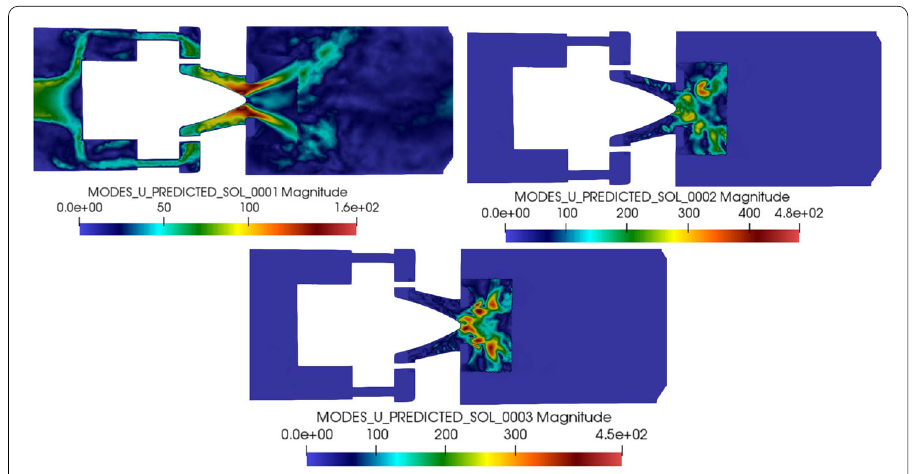
Fig. 28 Locally updated velocity modes (cid:9) 1 , (cid:9) 2 , (cid:9) 3 , with respect to the HF solution in the RFD associated with the second configuration. Only the first mode is of global support (cid:2) and starting from the second mode they have a local support (cid:2)